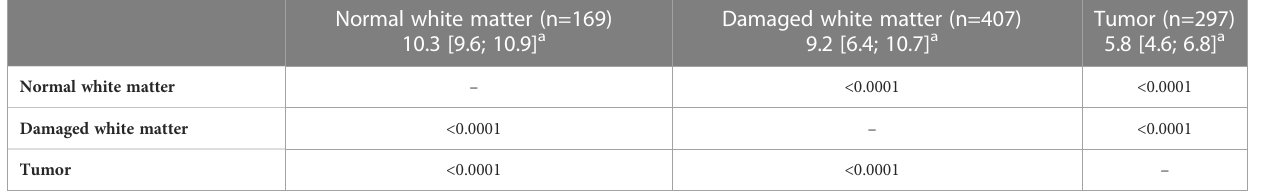
p-values for the alternative hypothesis of the Mann-Whitney U-test about the presence of differences between the compared groups are indicated. a Me [Q1;Q3] – where Me – median, Q1, Q3 – values of 25 th and 75 th percentiles,